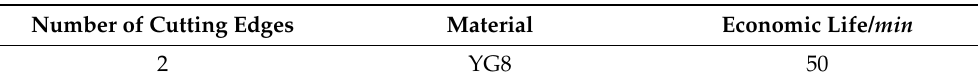
Table 5. Drill Bit